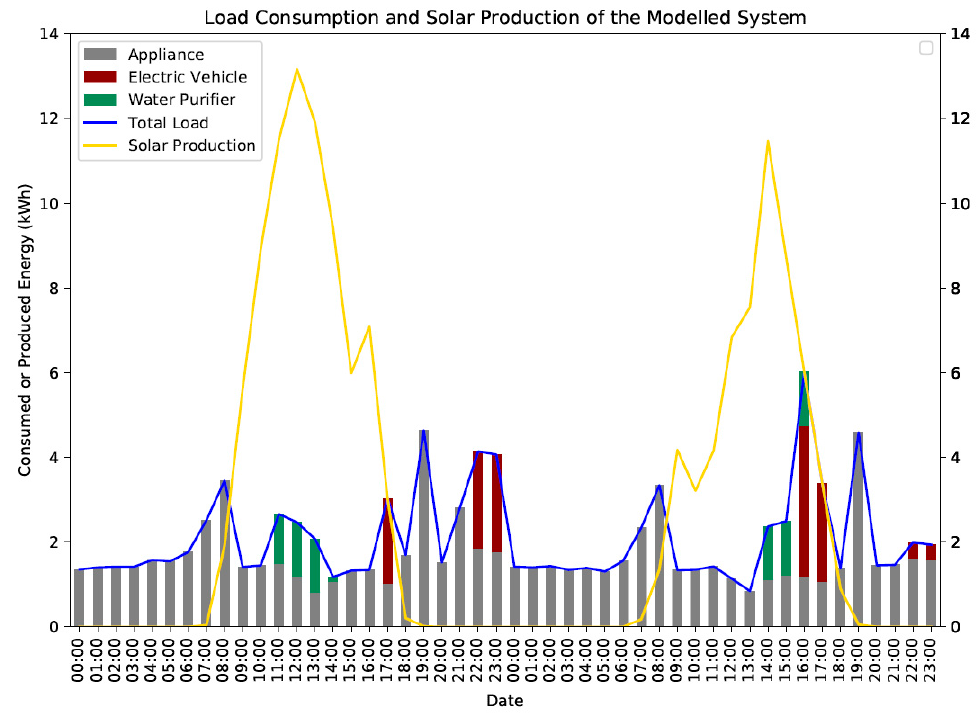
Figure 10. Load scheduling example in March.